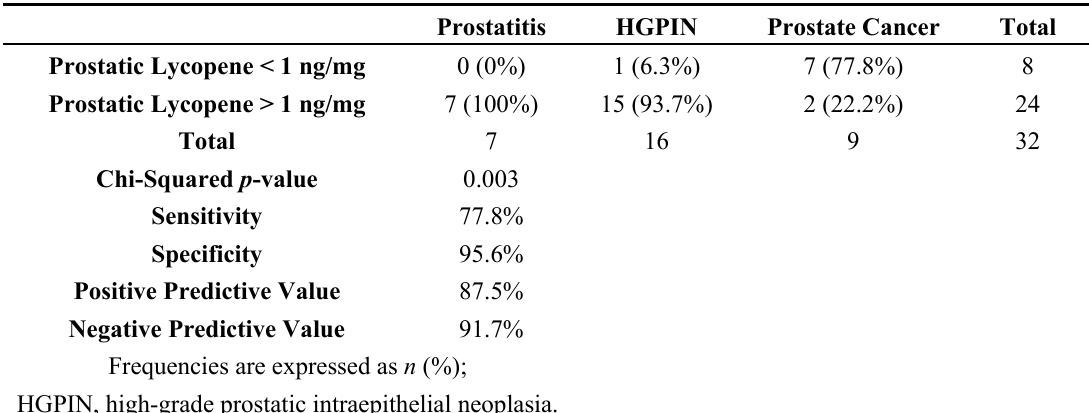
Table 2. Contingency table showing the relationship between diagnosis and low prostatic lycopene levels according to 1 ng/mg cut-off value, which corresponds to the lowest quartile of the distribution. Prostatitis